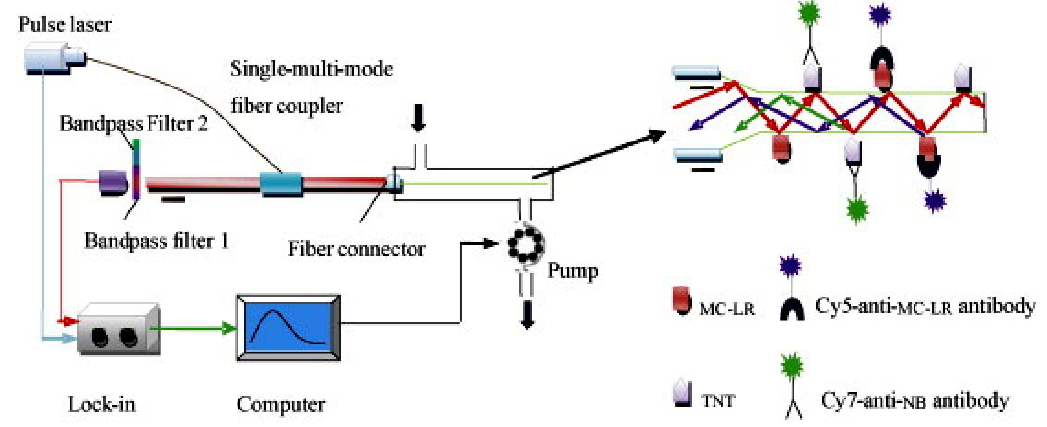
Figure 5. Setup of a fiber-optical immunosensor for the parallel detection of microcystin-LR and TNT. Reprinted with permission from [104]. Copyright (2010) Elsevier.